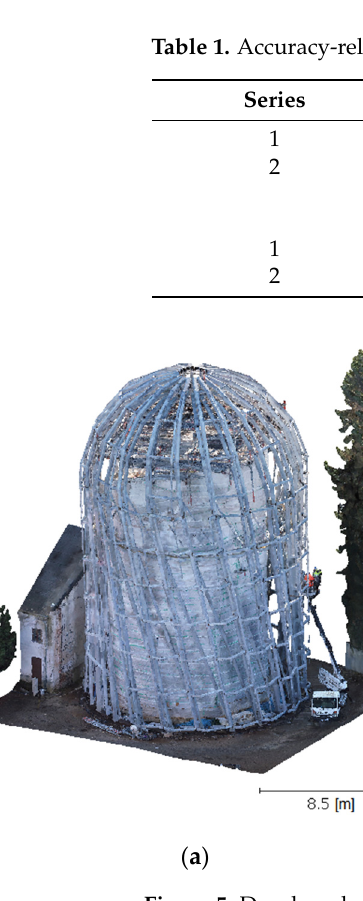
Figure 4. TLS and UAV data acquisition diagram for high structures.